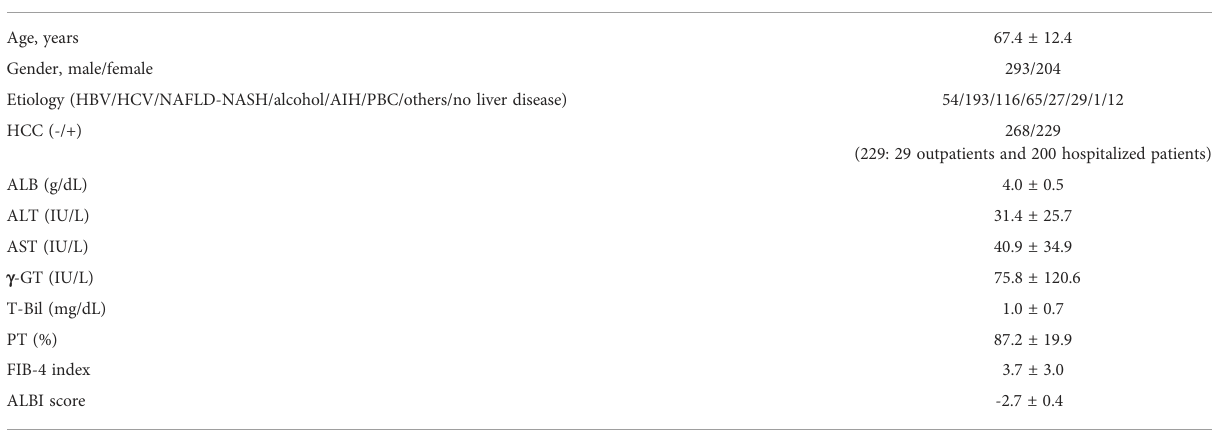
(Figure 2D). In contrast, FIB-4 index and ALBI score measurements were not changed based on BCLC and HCC stages, although the FIB-4 index value was increased in BCLC B when compared to BCLC 0 ( P < 0.05) (Figures 2C, D). Serum fCK18 levels, as well as AFP and DCP, were signi fi cantly elevated in the HCC up-to-seven group (largest tumor diameter [in cm] + tumor number > 7) (23) ( P < 0.0001), while FIB-4 index and ALBI score was the same between groups in or out of the HCC up-to-seven criteria (Figure 2E). These results indicate that serum fCK18 levels are associated with HCC progression and may re fl ect HCC-driven apoptosis in addition to hepatocellular damage.